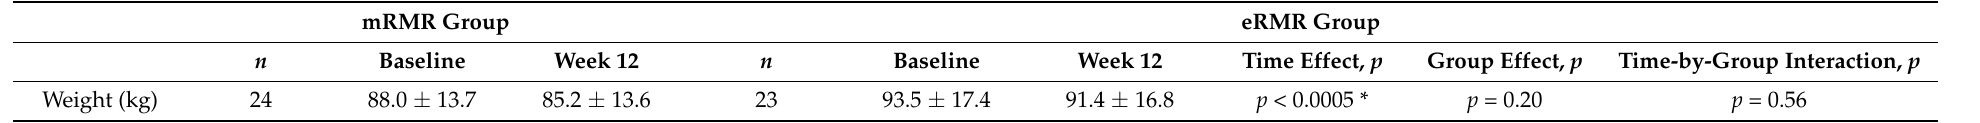
Table 3. Primary outcome weight pre and post intervention.